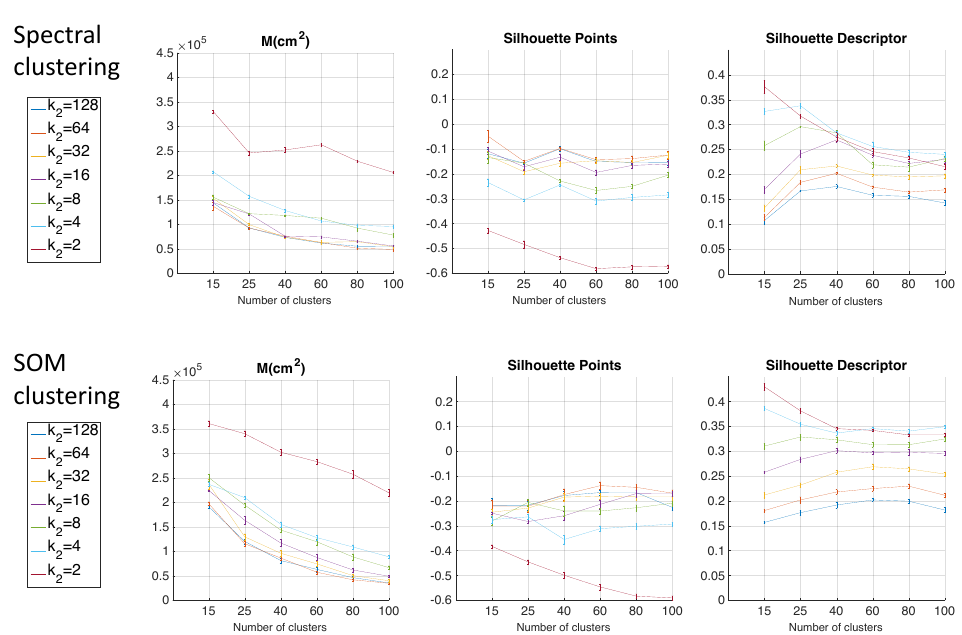
Figure 7. Results of the two clustering methods: average moment of inertia, average silhouette of points, and average silhouette of descriptors vs. number of clusters, when using HOG in the Quorum V